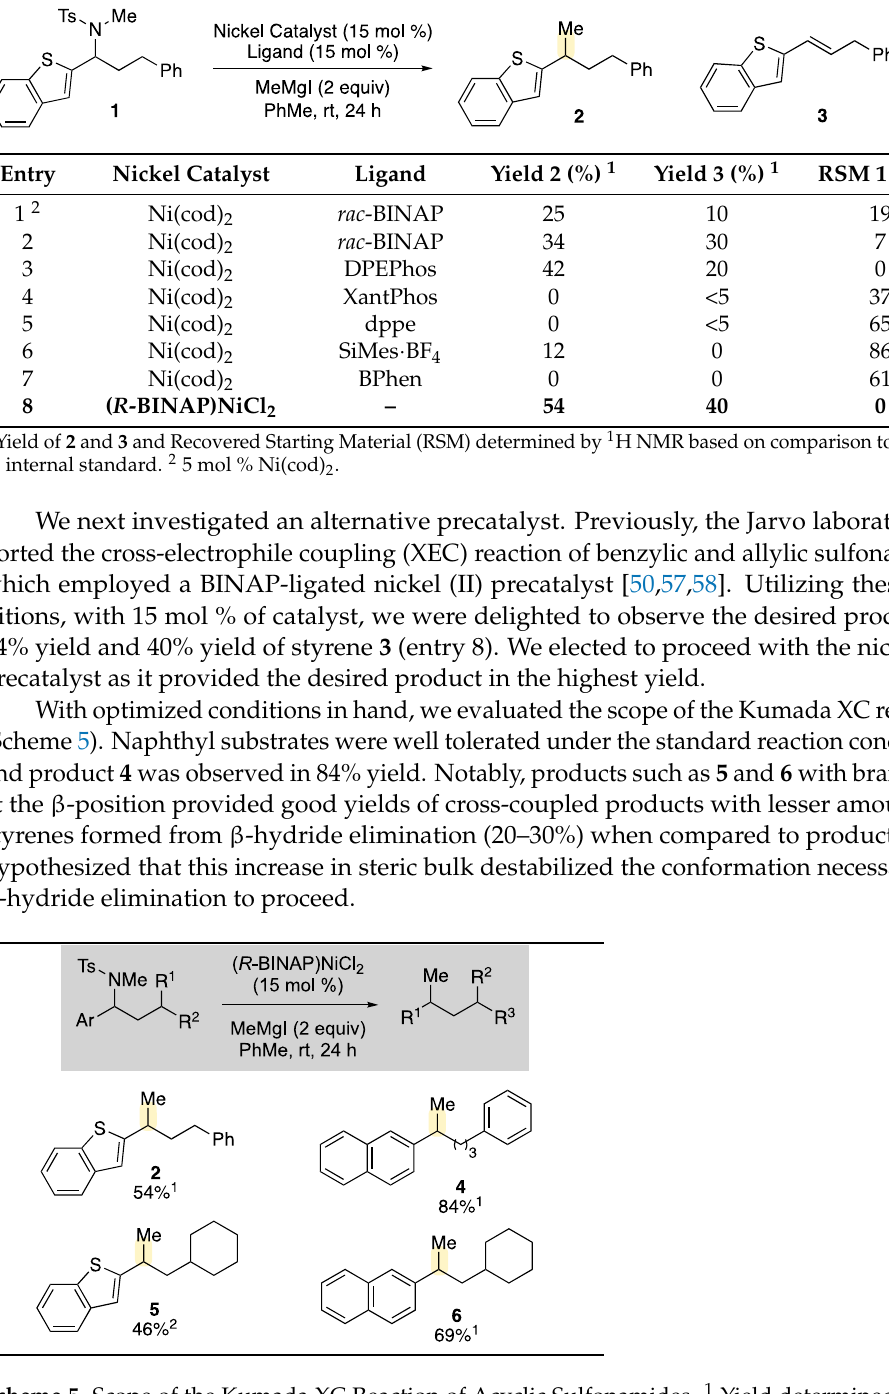
Table 1. Optimization of Kumada XC Reaction of Benzylic Sulfonamides.